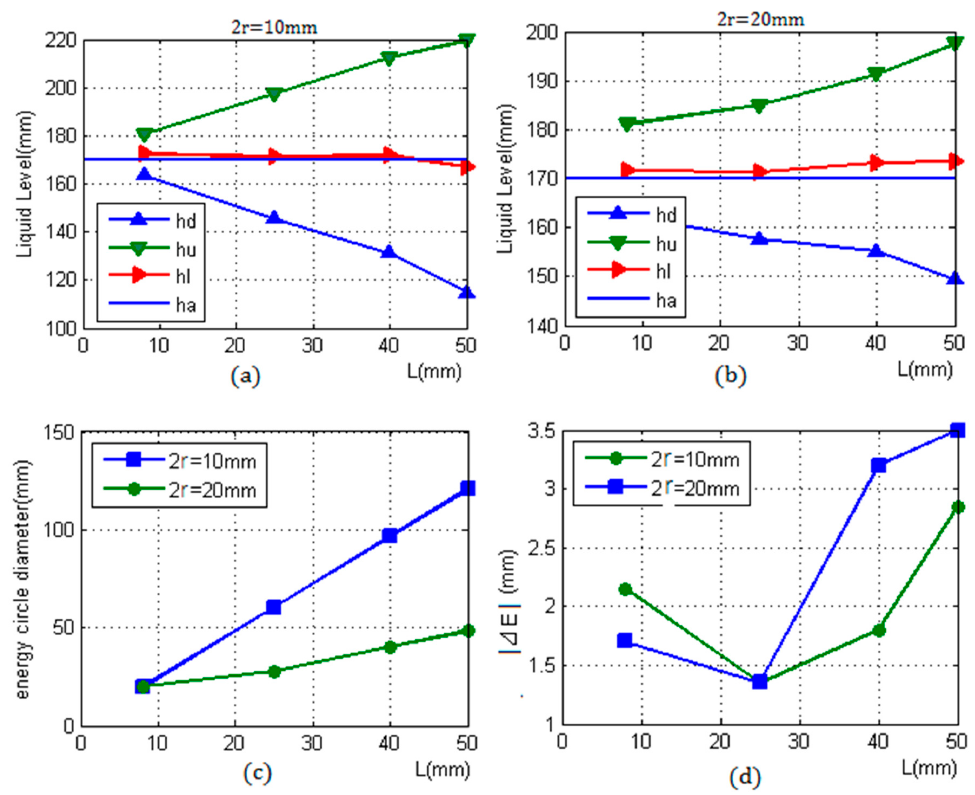
Figure 10. Two detection results of different sensors: ( a ) 2r = 10 mm; ( b ) 2r = 20 mm; ( c ) comparison of energy circle diameters for two kinds of sensors; and ( d ) errors.